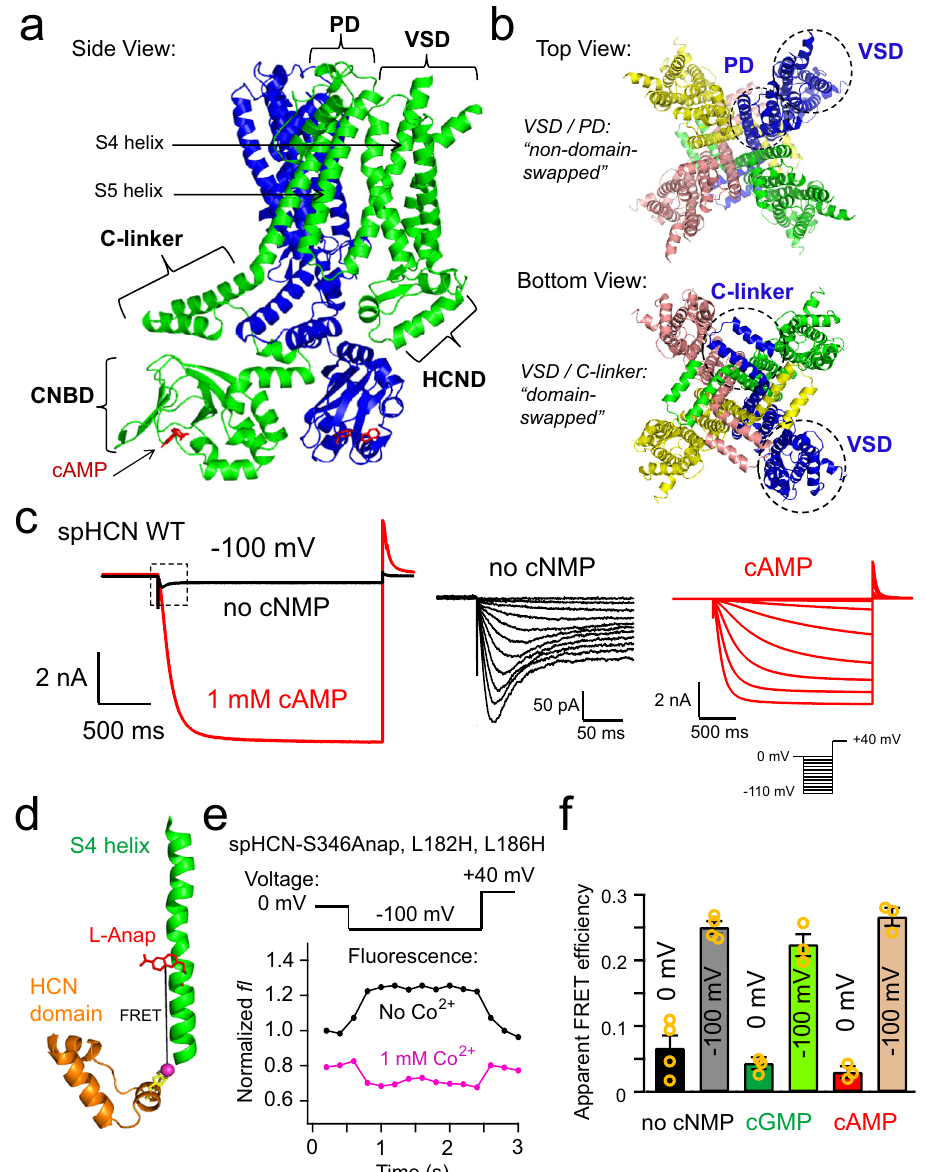
Fig. 1 Structural features and properties of spHCN channels in the presence and absence of cyclic nucleotide. a Side view of a homology structure of spHCN channels based on the cryo-EM structure of human HCN1 (PDB 5U6P), highlighting the proximity of the S4 and S5 transmembrane helices relative to the C-linker domain of the adjacent subunit. Only two adjacent subunits are shown. b Top and bottom views of the same homology model of spHCN showing the arrangement of its quaternary structure. c Left: spHCN channel currents elicited by a hyperpolarizing voltage pulse from 0 to − 100 mV, in the presence (red) or in the absence (black) of 1 mM cAMP. Middle: Channel inactivation without cyclic nucleotide, elicited by a series of hyperpolarizing voltages from 0 to − 120 mV (with 10 mV steps), happened during the time frame indicated by the dashed box on the left panel. Note the blown up current and time scale. Right: Channel currents elicited by a series of hyperpolarizing voltages from 0 to − 120 mV (with 10 mV steps), in the presence of 1 mM cAMP. d Left, cartoon showing the FRET between S346Anap in the S4 helix and Co 2 + chelated by a di-histidine L182H and L186H in the HCN domain. e Fluorescence measurements for spHCN-S346Anap, L182H, and L186H channels with a − 100 mV voltage pulse, before and after applying 1 mM Co 2 + . f Summary of the FRET ef fi ciencies measured for spHCN-S346Anap, L182H, and L186H channels at 0 and − 100 mV in the absence of cyclic nucleotide monophosphate (no cNMP; n = 4 independent patches), and the presence of cGMP ( n = 3 independent patches) or cAMP ( n = 3 independent patches). Data shown are mean ± s.e.m. Source data are provided in the Source Data fi